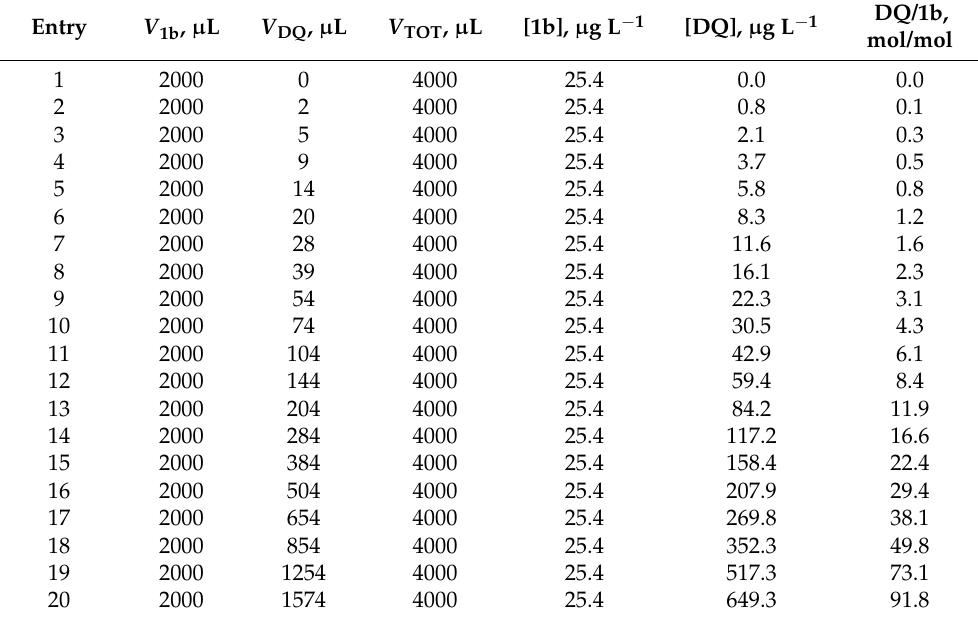
Table 4. Experimental data for the determination of spectra reported in Figure 6. The V 1b and V DQ